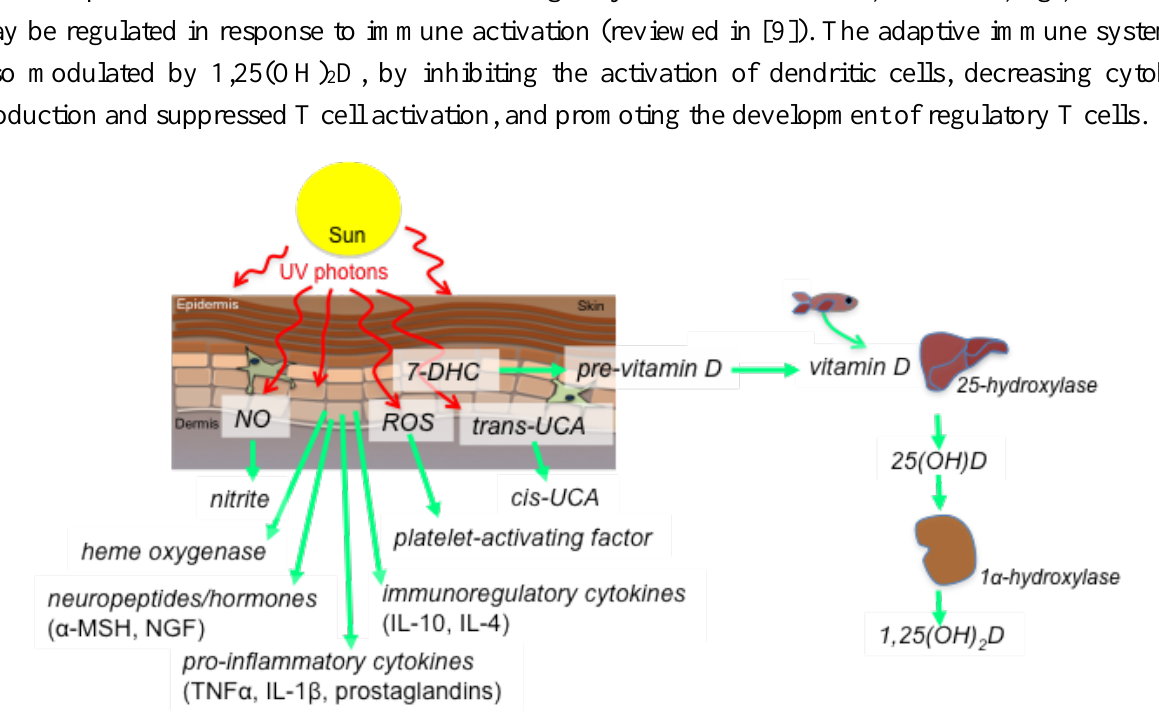
Figure 1. Skin exposure to ultraviolet (UV) photons from sunlight results in the synthesis of effector molecules that modulate immune and metabolic processes. These include: skin release of nitric oxide (NO), increasing serum levels of nitrite; initiation of the conversion of precursor molecules such as reactive oxygen species (ROS), trans -urocanic acid (UCA) and 7-dehydrocholesterol (7-DHC) into platelet-activating factor, cis -UCA and 1,25- dihydroxyvitamin D (1,25(OH) 2 D, calcitriol), respectively; and, the release of heme oxygenase, neuropeptides and neurohormones (e.g., α-melanocyte stimulating hormone (α-MSH), nerve growth factor (NGF)), immunoregulatory (interleukin(IL)s-4 and -10) and pro-inflammatory (tumor necrosis factor-α, IL-1α, prostaglandins) cytokines. Sun exposure of the skin results in systemic production of active vitamin D (1,25(OH) 2 D) through hydroxylation of vitamin D in the liver and 25-hydroxyvitamin D (25(OH)D) in the kidneys. These events can also occur locally in skin and immune cells that express the hydroxylating